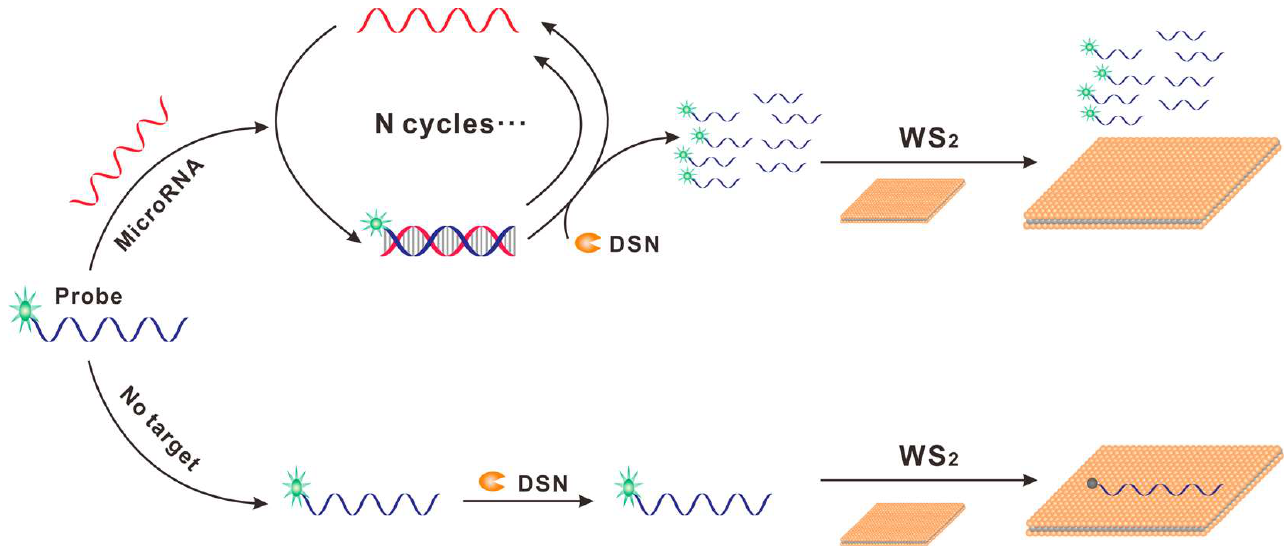
Figure 12. Schematic Illustration of the miRNA Assay Based on WS 2 Nanosheet Mediated Fluores- cence Quenching and Duplex-Specific Nuclease Signal Amplification (Reprinted with permission from Ref. [154]. Copyright 2014, Analytical Chemistry).